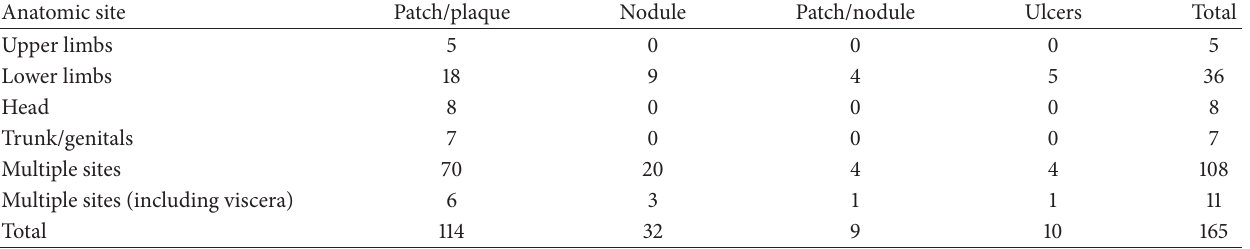
Table 2: Distribution of mucocutaneous KS lesions.